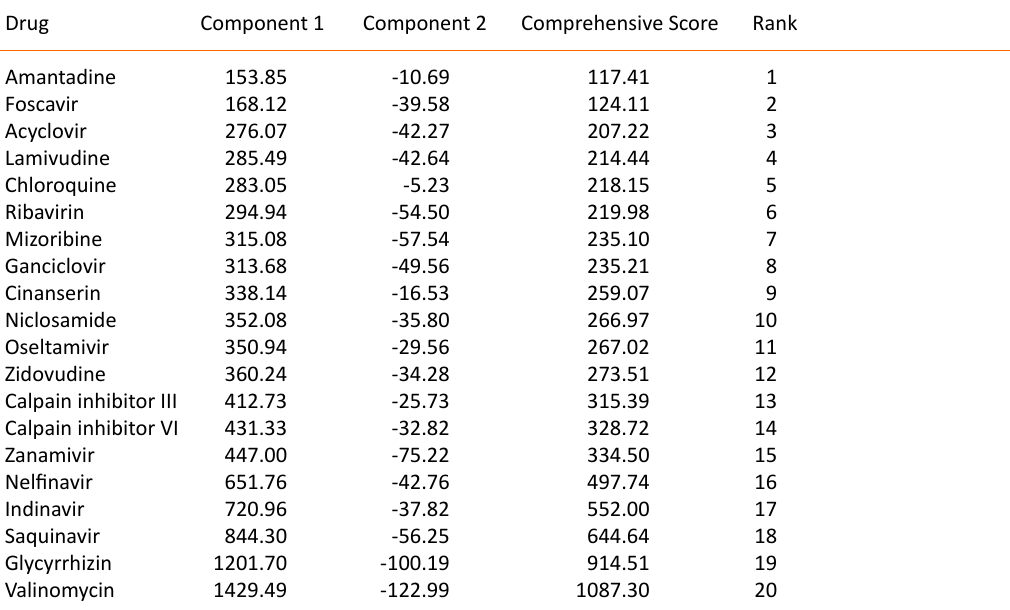
Table 4. Comprehensive evaluation of the antiviral drugs based on the identified principal components